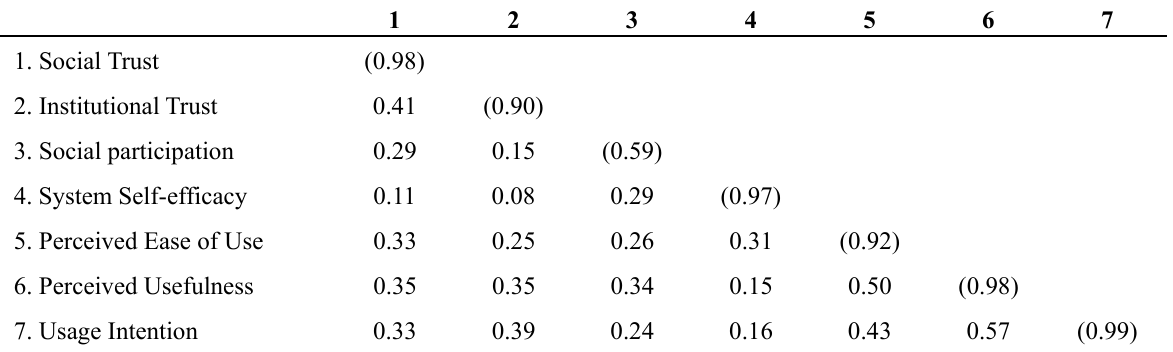
Table 3. Comparison of Squared Correlation and Average